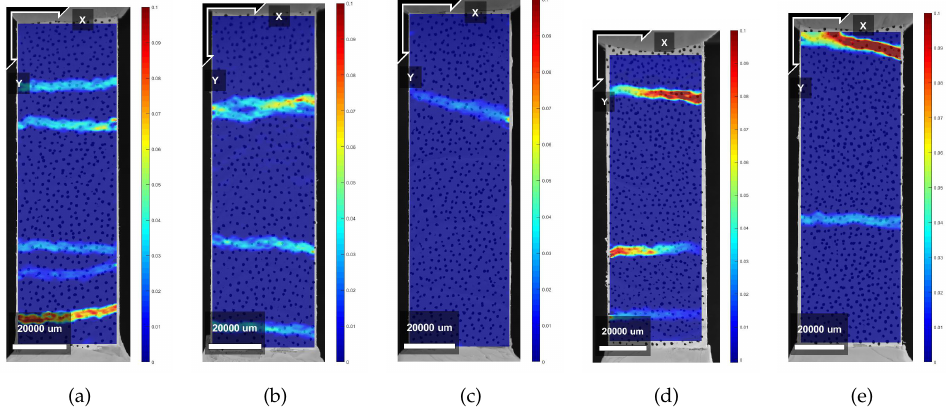
Figure 9. Crack pattern obtained from DIC analysis on X samples—Vertical Deformations.